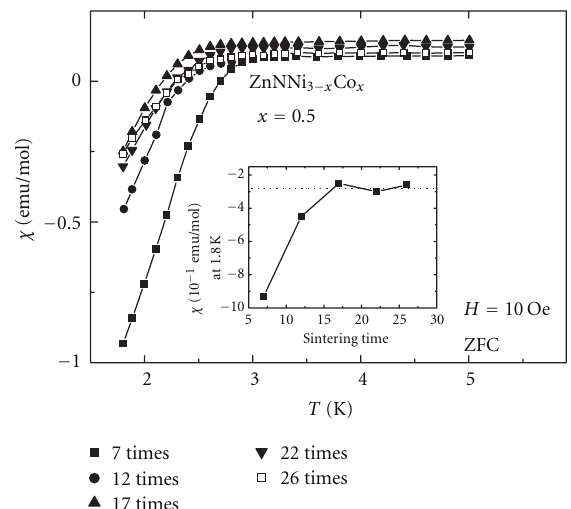
Figure 6: Temperature-dependent magnetic susceptibilities of x = 0 . 5 samples with various numbers of sintering cycles. The inset shows χ at 1.8 K as function of sintering cycle